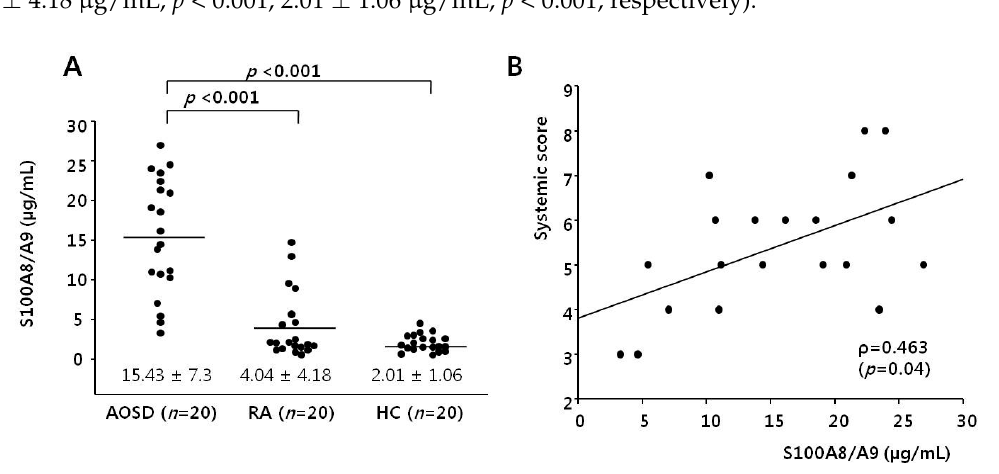
Figure 1. ( A ) Levels of S100A8/A9 in 20 active adult-onset Still’s disease (AOSD) patients, 20 rheumatoid arthritis (RA) patients, and 20 healthy controls (HCs). Data are expressed as the means ± standard deviation (SD). A Mann-Whitney U -test was used to perform the statistical analysis; ( B ) the levels of S100A8/A9 correlated with the systemic scores in AOSD patients ( r = 0.463, p =